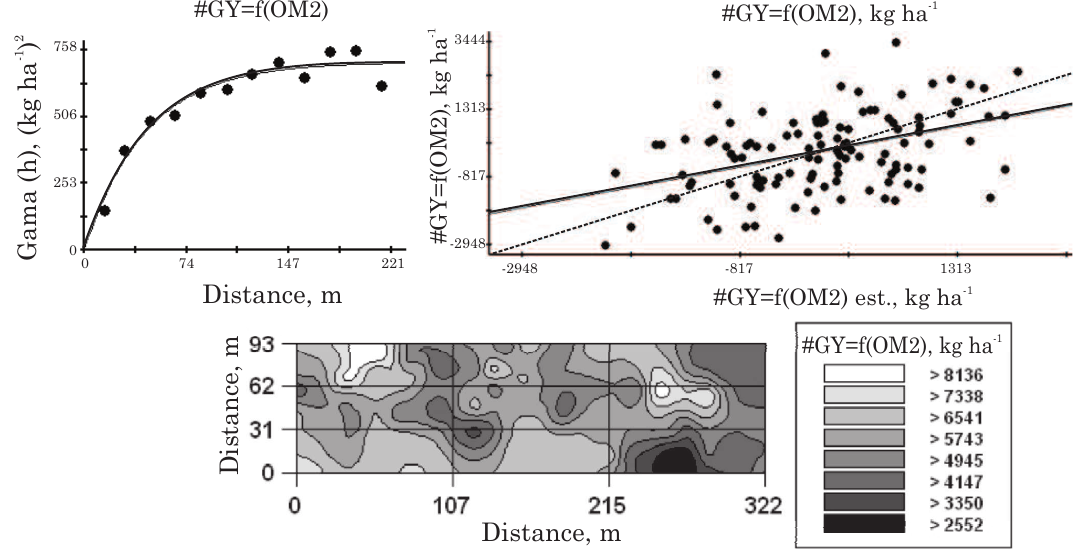
Figure 4. Cross-semivariograms, cross-validation and co-kriging maps of rice grain yield as related to organic matter content of a Typic Acrustox under